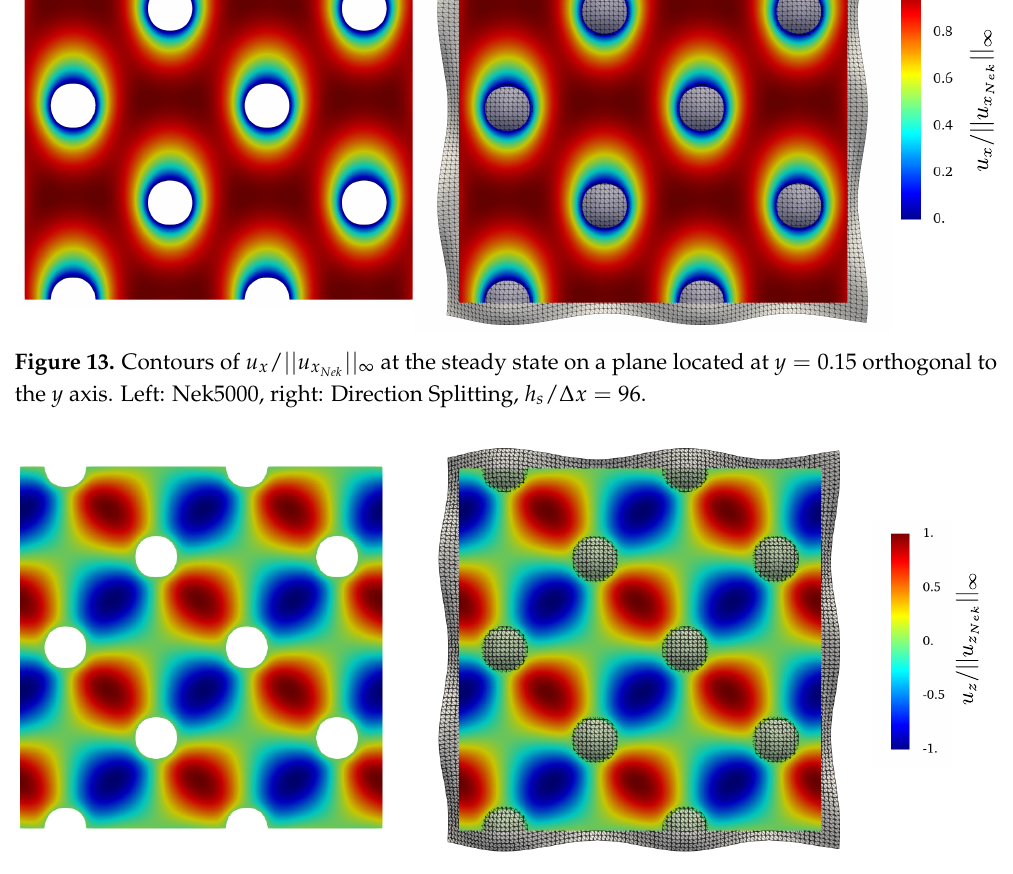
|| ∞ at the steady state on a plane located at y = 0.15 orthogonal to Figure 14. Contours of u z / || u z Nek the y axis. Left: Nek5000, right: Direction Splitting, h s / ∆ x = 96. We also compare velocity profiles for u x , u y , u z along the lines intersecting the top wall orthogonally and the points ( x 1 = 0.5, z 1 = 0.75 ) , ( x 2 = 1.0, z 2 = 0.75 ) and ( x = 0.86, z = 0.92 ) (see Figure 15). ( x ) and ( x ) are chosen because they 3 3 2 , z 2 1 , z 1 are located respectively on the highest and lowest amplitude of the bottom wall, i.e., f ( x 1 , z 1 ) = 0.2 and f ( x 2 , z 2 ) = − 0.2. u z = 0 at these locations so we select ( x 3 , y 3 ) to be able to have a comparison for the third component of the velocity.